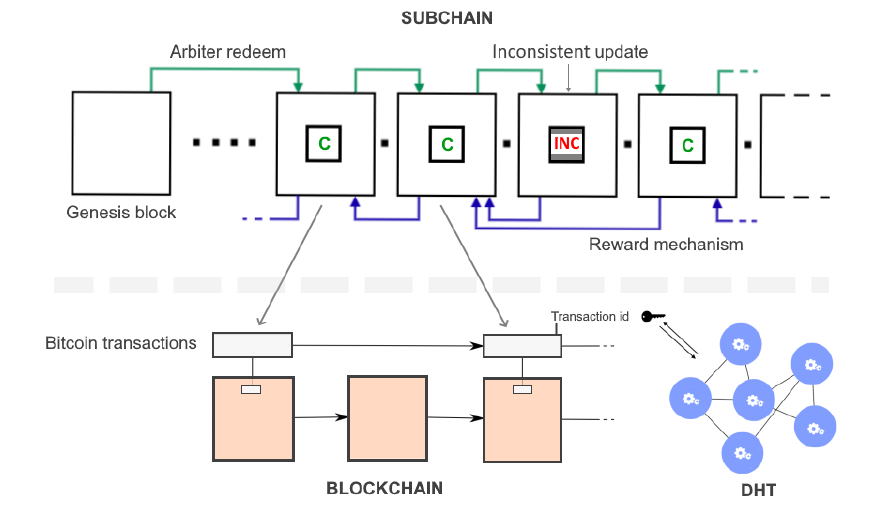
Figure 6. Abstract scheme of the implemented